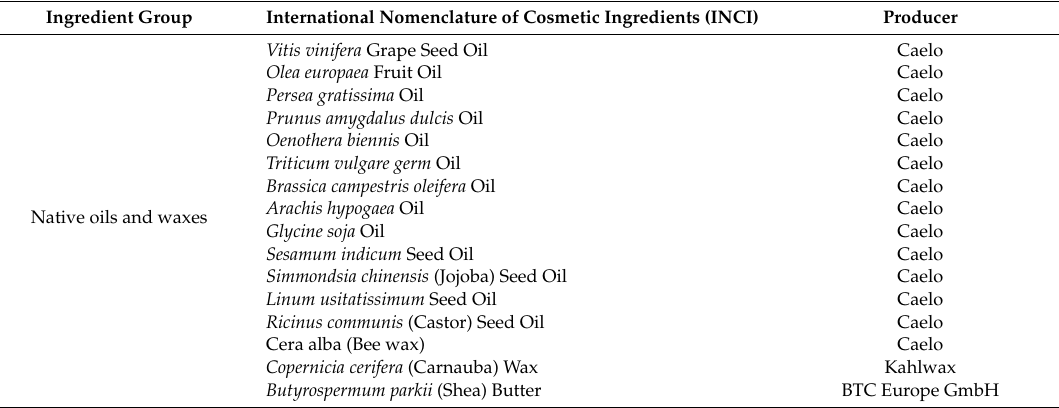
Table 1. Tested cosmetic